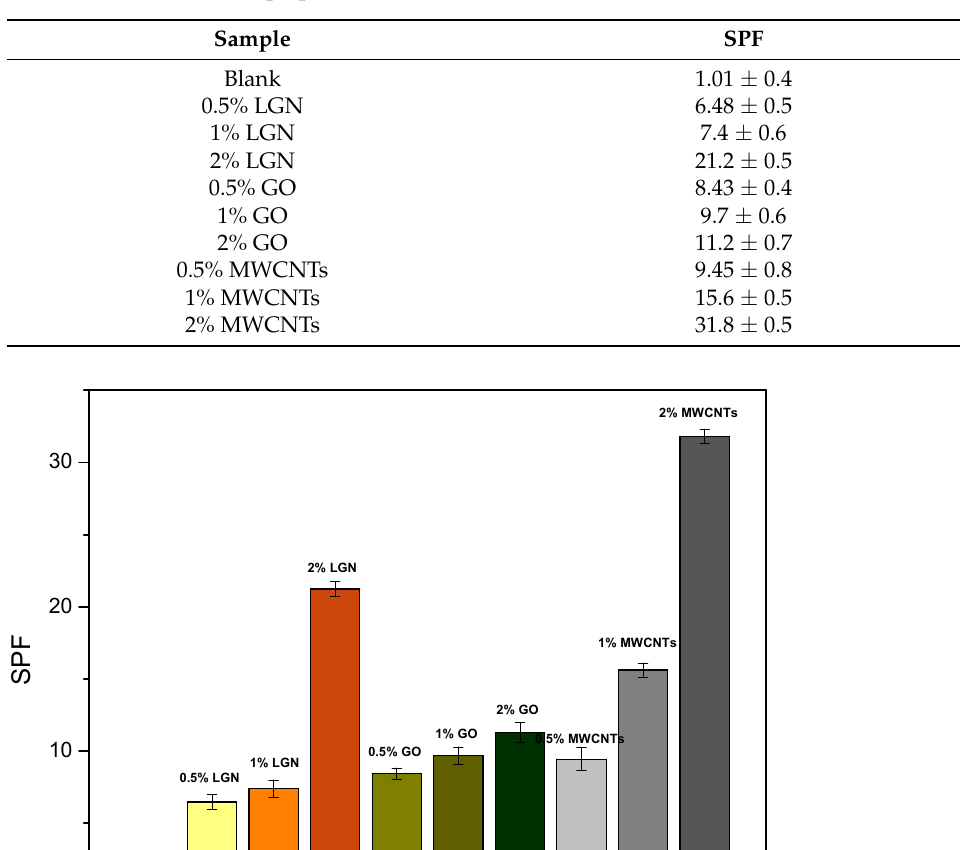
Table 2. SPF values of the prepared emulsions. Figure 5. pH values obtained from the prepared emulsions during storage stability tests.